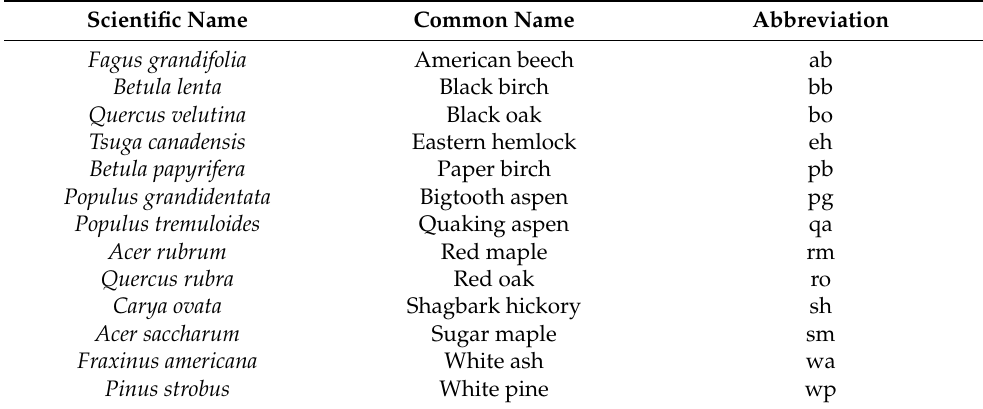
Table 3. Scientific and common names of tree species classified in this